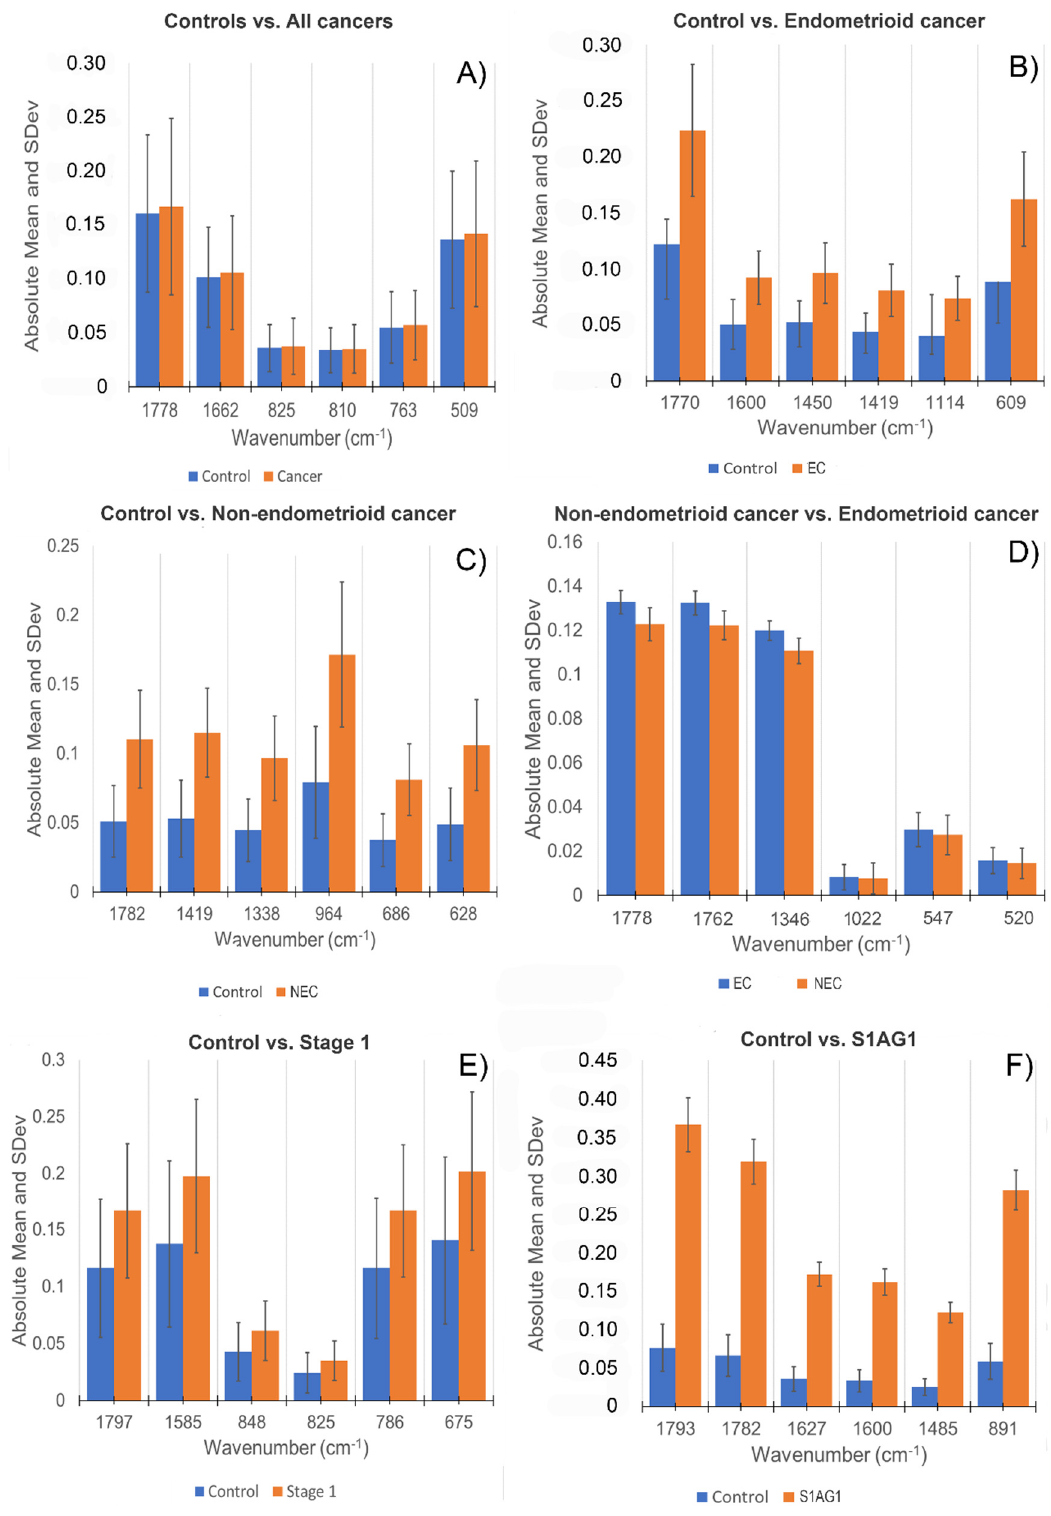
Figure 4. Bar plots from the spectral distribution and the mean absorbance, of the most discriminatory peaks found on ( A ) Controls vs. all cancers, ( B ) Controls vs. endometrioid cancers (EC), ( C ) Controls vs. non-endometrioid cancers (NEC), ( D ) Non-endometrioid cancers vs. Endometrioid cancers, ( E ) Controls vs. Stage 1 cancers, and ( F ) Control vs. Stage 1 grade 1A cancer classes.